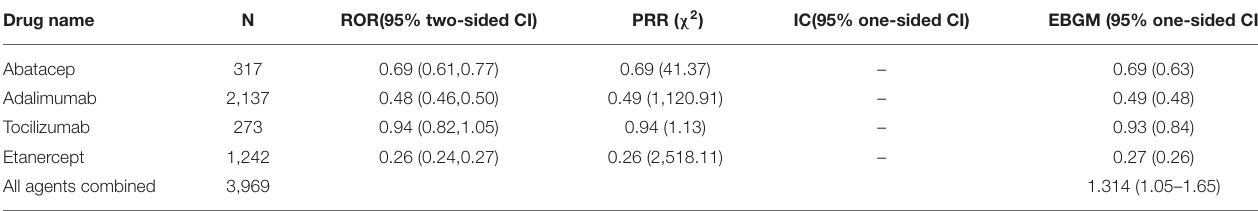
TABLE 4 | Associations of different single drugs with cardiotoxic events.